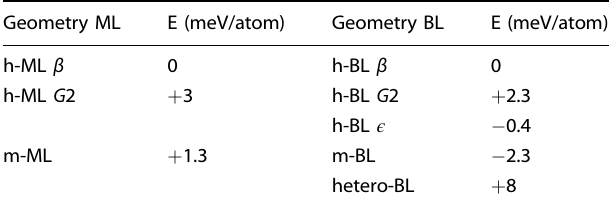
Table 1. Energetic stability of monolayer (ML) and bilayer (BL) GaTe with respect to the corresponding structure in the hexagonal β form whose ground state total energy is set to